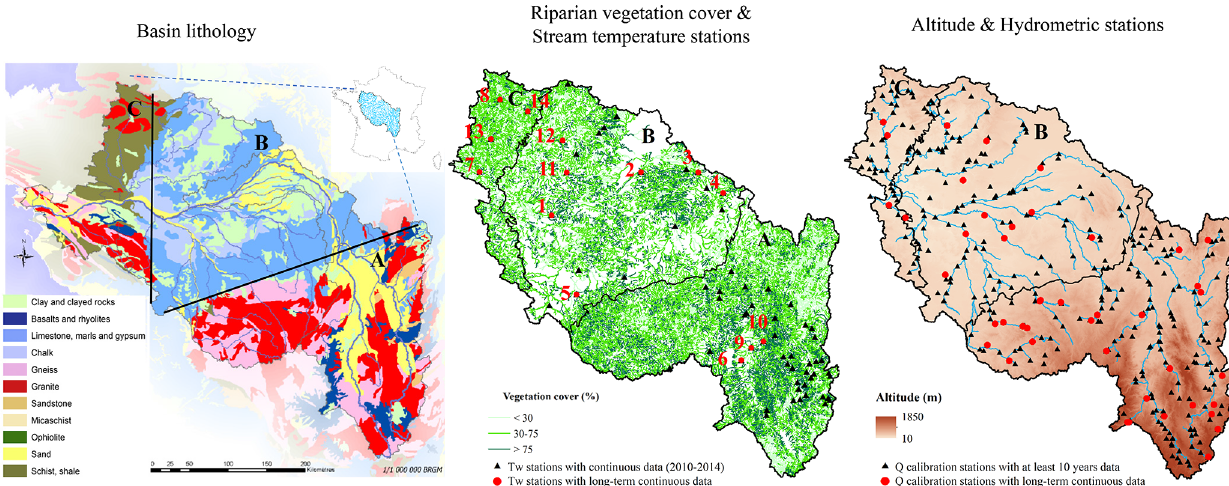
Figure 1. Maps of the Loire basin. Left panel: basin lithology adapted from Moatar and Dupont (2016), based on original data from BRGM (French Geological Survey). The figure in the top right corner of the left panel shows the position of the Loire River basin in France. Middle panel: riparian vegetation cover (provided by Valette et al., 2012) and T w stations. All T w stations were used to assess the performance of the T-NET thermal model (see Table S5), but only the ones with long-term data (in red) were used to assess the T-NET thermal model accuracy for long-term trends. Complete information on T w stations with long-term continuous data is provided in Table 1. The numbers in red in the middle panel correspond to the ID of long-term T w stations in Table 1. Right panel: altitude (IGN, 2011) and hydrometric stations (extracted from the French national Banque Hydro database: http://www.hydro.eaufrance.fr/, last access: 12 July 2021). All hydrometric stations were used for calibrating the EROS hydrological model (see Table S2), but only stations on the French Reference Hydrometric Network (RHN) with long-term data (in red) were used to assess the EROS hydrological model performance on long-term trends (see Table